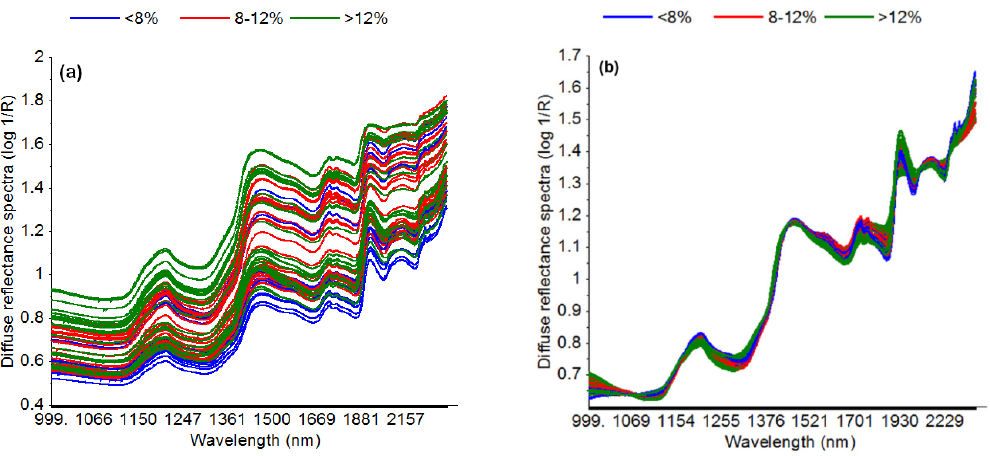
Figure 2. Diffuse reflectance spectra (log 1/R) of calibration model. Raw spectra ( a ); EMSC (extended multiplicative scatter) corrected spectra ( b ).